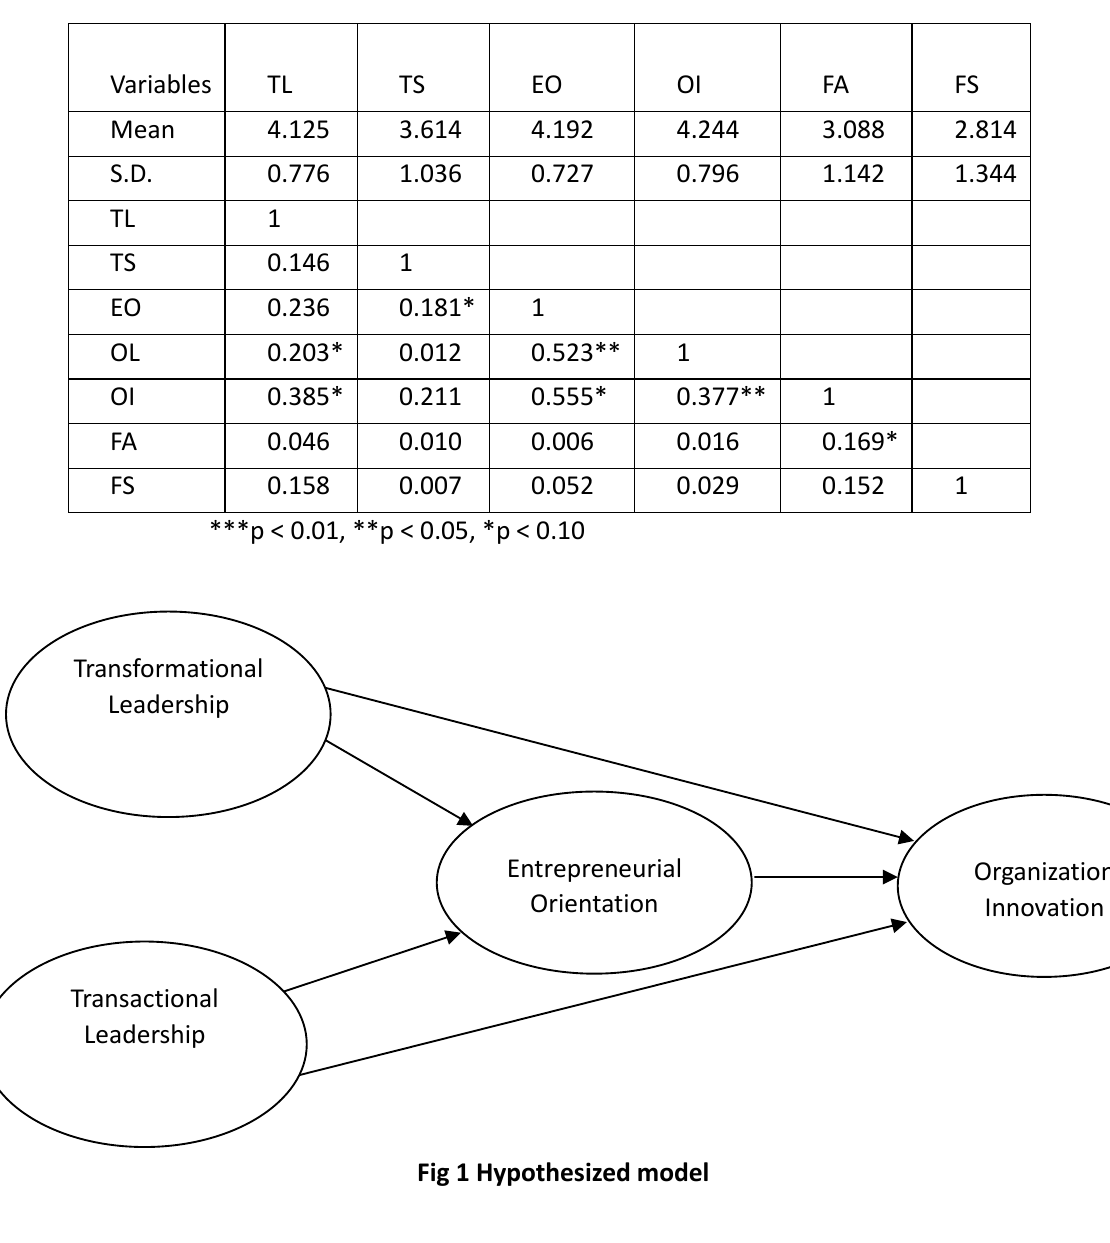
Factor Correlations, Means, and Standard Deviations